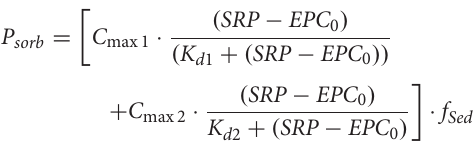
TABLE 2 | Connectivity levels (cl), average hydrological connectivity, and SRP concentrations of water bodies (wb) with different hydrological connectivity compared with Danube River concentrations (D) for two hydrological situations—flood and no-flood—as a basis for upscaling. wb cl (m a.s.l.)